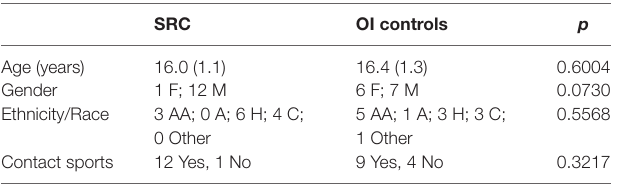
Table 1 | Mean (sD) demographic characteristics for the src and Oi control